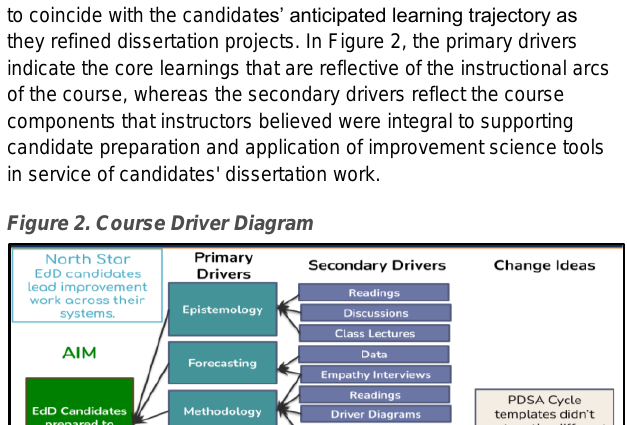
Course Learning Activities